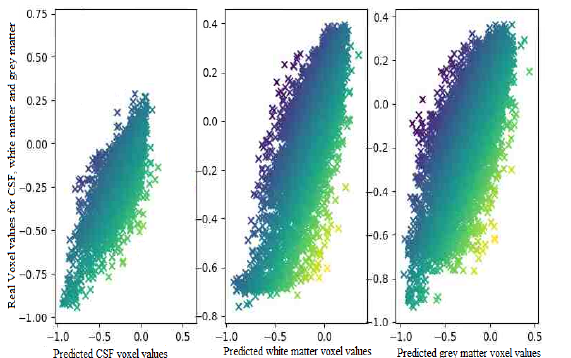
Figure 8. The Average voxel values in the translated image and the ground truth for 10